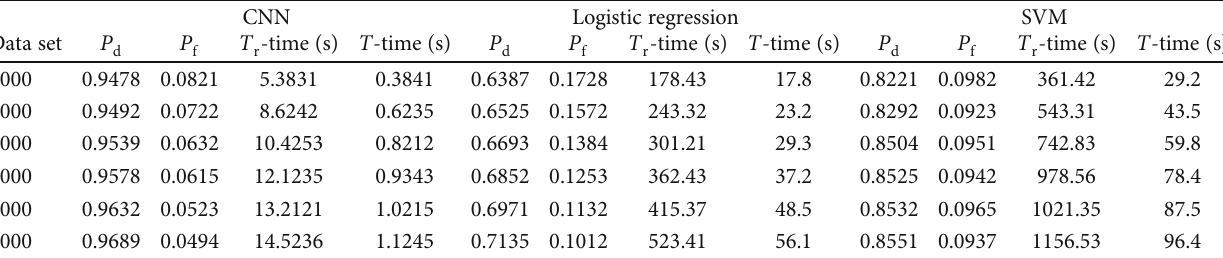
Table 5: Comparison of three algorithms.